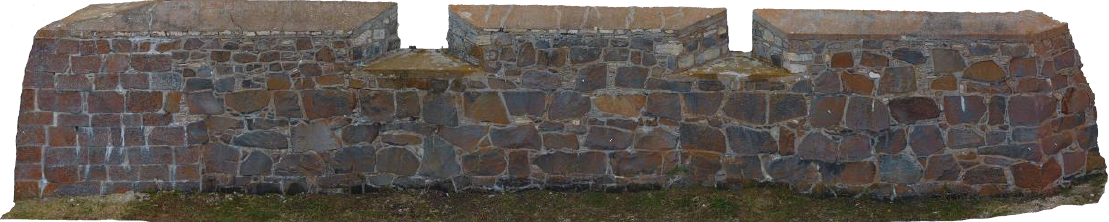
Figure 9: Orthophoto of Wall Section